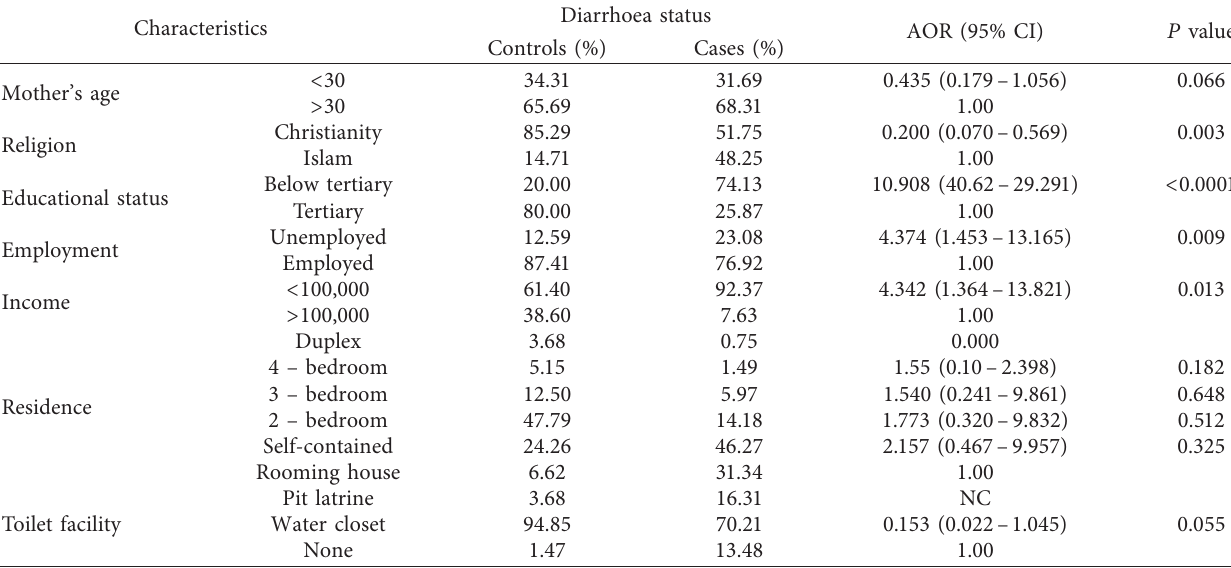
Table 4: Multivariate Analysis of mothers/caregivers’ sociodemographic